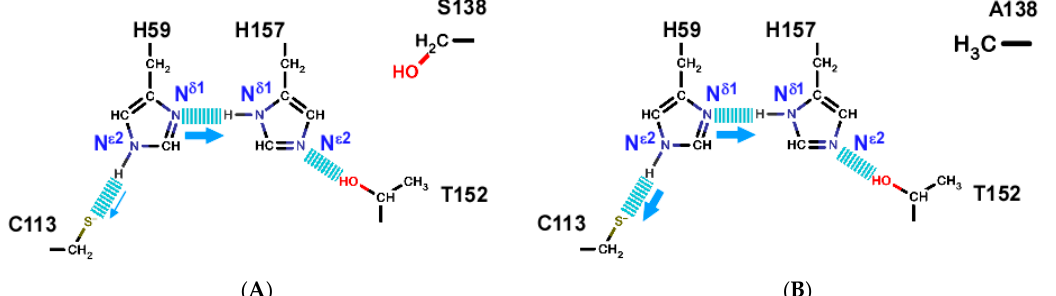
Figure 7. Allosteric changes to the hydrogen-bond network in Pin1-PPIase induced by the S138A mutation. ( A ) The hydrogen-bond network identified in the wild-type Pin1 PPIase according to the high-resolution crystal structure of Par14 [27]. H59 forms a stronger hydrogen bond to H157 than to C113, as previously reported [13]; ( B ) The S138A mutation strengthens the hydrogen bond between H59 and C113 while maintaining a strong hydrogen bond to H157. The thickness of the arrow represents the strength of hydrogen bond; thicker arrow means stronger bond.